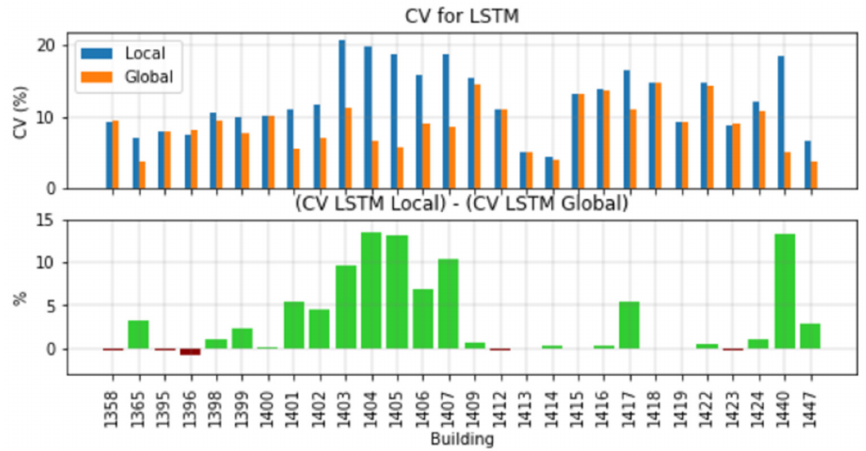
Figure 7. Comparison (in the upper figure) and difference (in the lower figure) between the CV obtained from local and global LSTM models on test set.